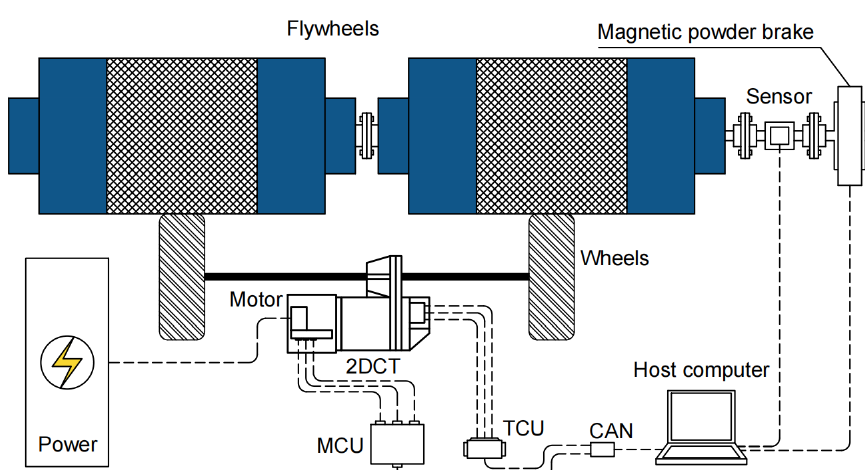
Figure 19. Testing rig composition frame.